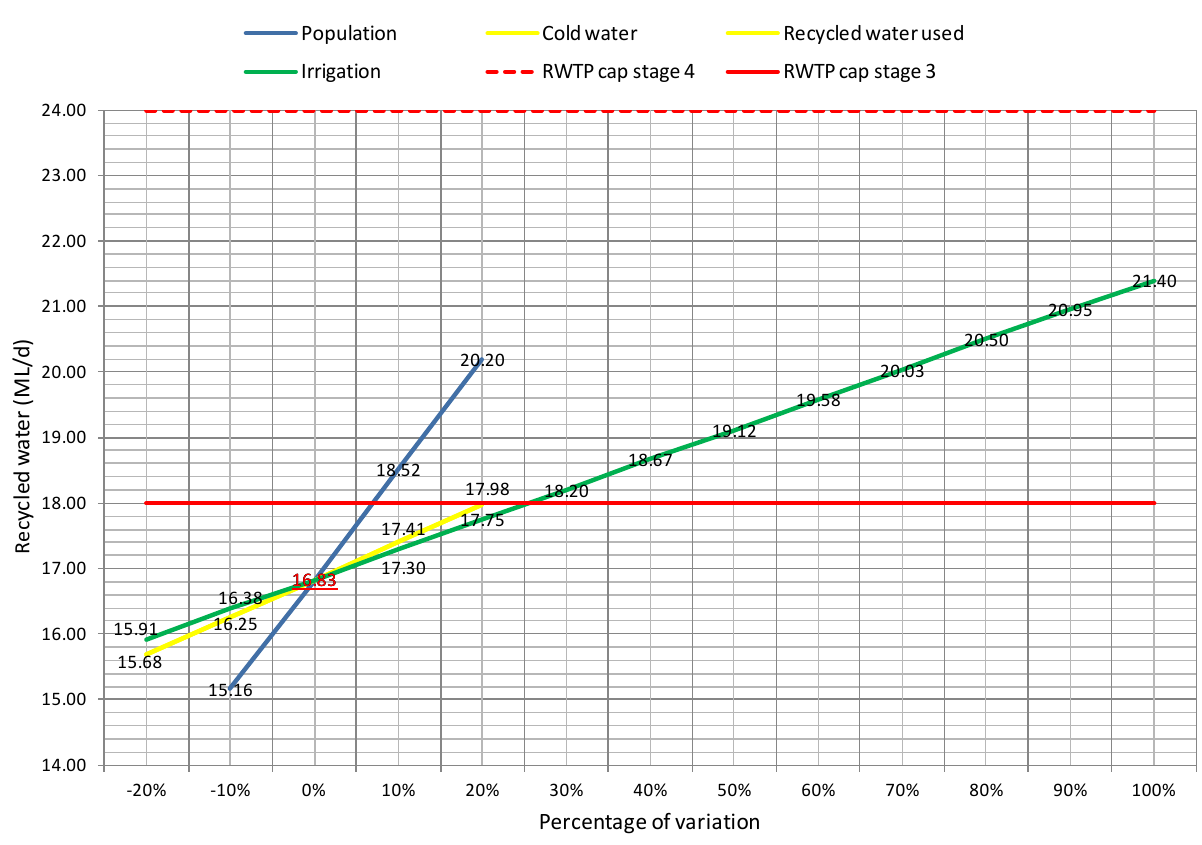
Figure 6. Spider graph for proposed scheme in 2056 (peak factor =